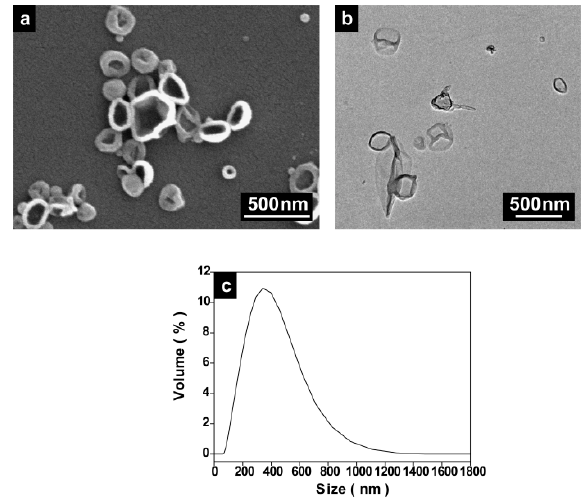
Figure 6. ( a ) SEM, ( b ) TEM, and ( c ) the size distribution of PU-15 prepared using 80%:20% of the continuous and dispersed phases, respectively.